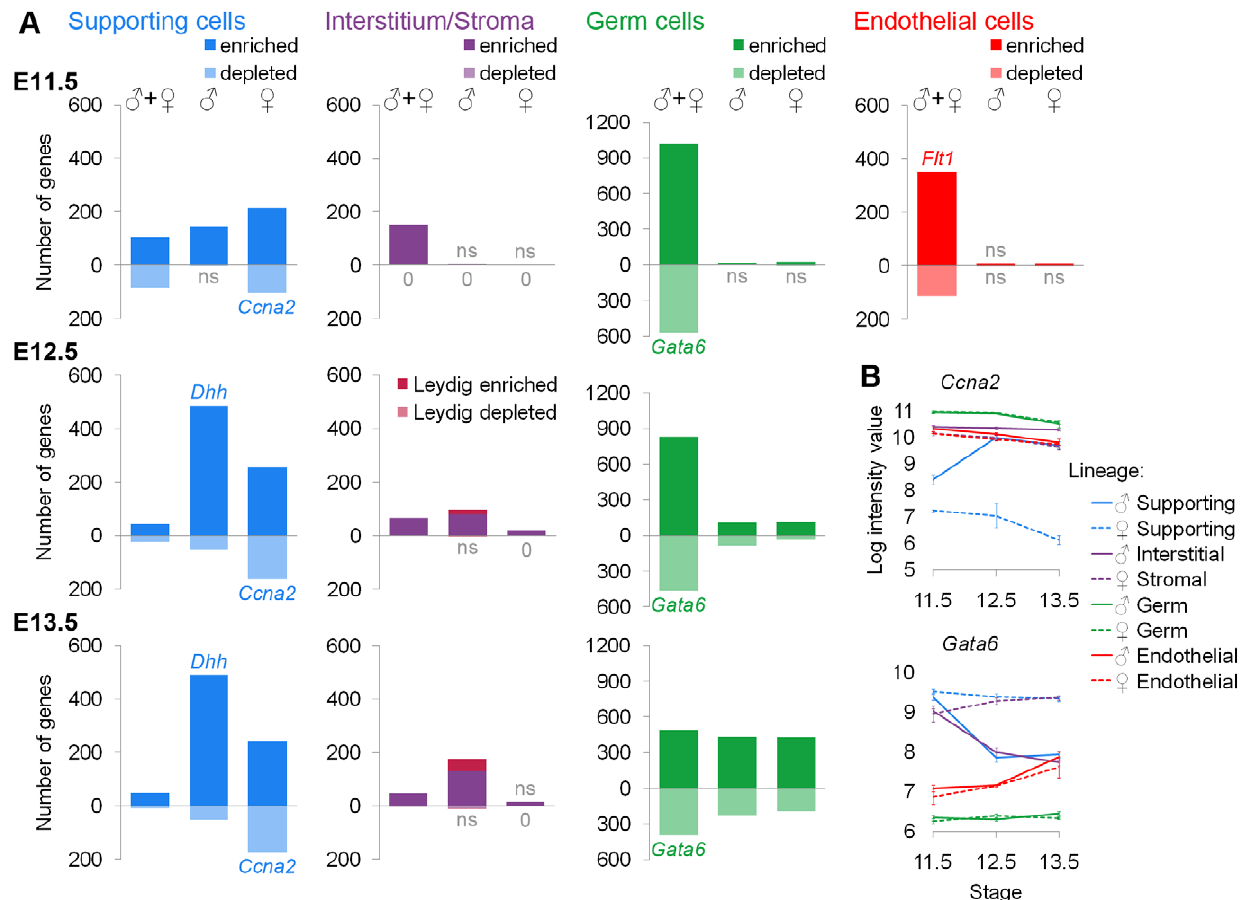
Figure 3. Lineage-specific enriched and depleted genes revealed distinct differentiation programs. (A) Graphs of the number of genes specific to each lineage. The gene lists and permutation tests are provided in Dataset S2. The ‘‘ = ’’ and ‘‘ R ’’ symbols indicate lineage-specific and sex- specific genes, while the ‘‘ = + R ’’ symbol indicates genes that are lineage-specific and sex-independent. Pale bars below the axis indicate genes that are depleted relative to other lineages. The E11.5 graphs are on the top row, the E12.5 graphs are in the middle, and the E13.5 graphs are on the bottom row. The germ cell Y-axis is scaled to accommodate the larger number of genes specific to this lineage. Leydig cell genes (burgundy) were separately identified by cross-referencing the endothelial and interstitial data and added to the bars for the XY interstitium. Lists with . 20% false positives are indicated by ‘‘ns’’. Lists with no genes are marked with ‘‘0’’. Some bars also have a colored gene name exemplifying the pattern within that category (the graphs for Dhh and Flt1 appear in Figure 1B). (B) Graphs of the log-transformed, normalized intensity values for genes that are sex- specifically ( Ccna2 ) and sex-independently ( Gata6 ) depleted. The error bars are standard error. Three lineages showed specific gene depletion in addition to enrichment. Each lineage had transcriptionally distinct progenitors as indicated by ‘‘ = + R ’’ genes at E11.5. Supporting cells were already in the midst of their sex-specific differentiation by E11.5 as indicated by genes in the ‘‘ = ’’ or ‘‘ R ’’ columns at E11.5, but the other cell types were sexually undifferentiated at E11.5.